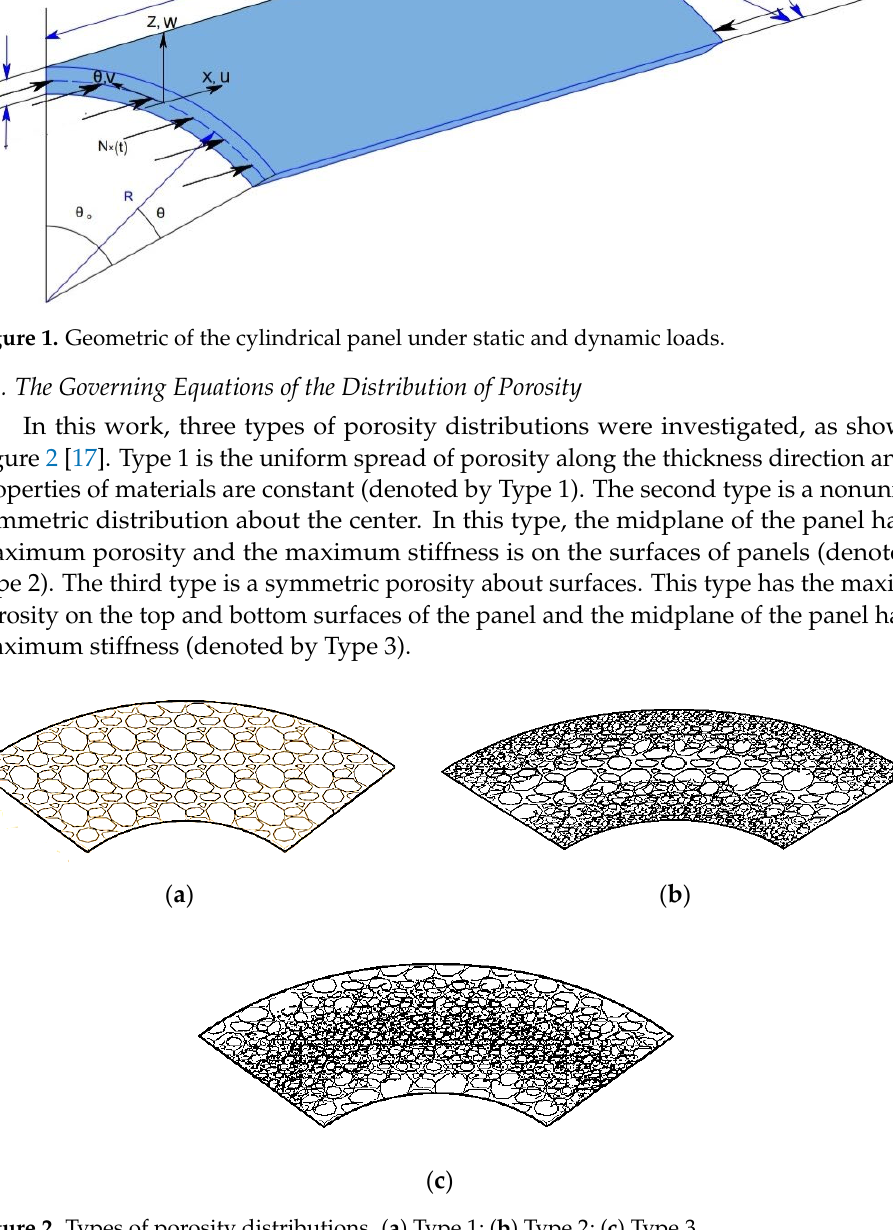
Figure 2. Types of porosity distributions. ( a ) Type 1; ( b ) Type 2; ( c ) Type 3.